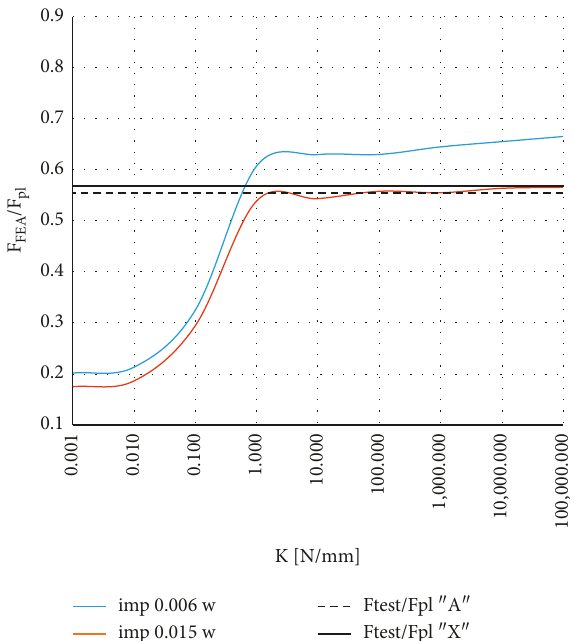
Figure 21: Numerical results for the normalized ultimate load as a function of spring stiffness of the 2,000mm column.